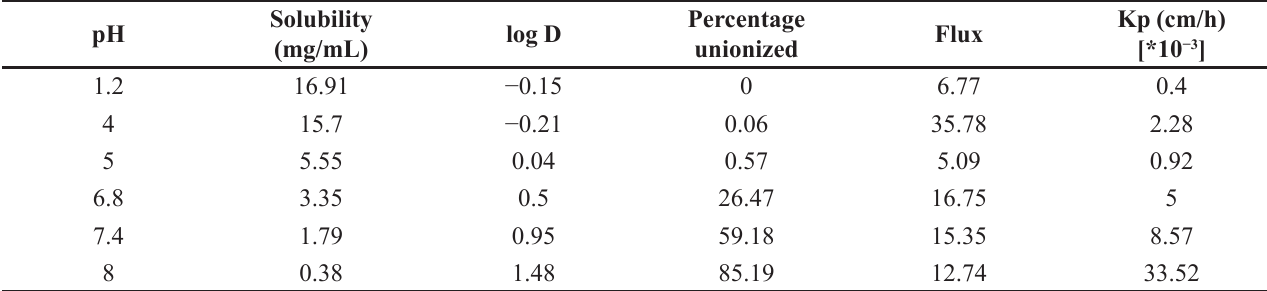
TABLE IV - Solubility, distribution coefficient, percentage unionized, and skin permeability parameters of olanzapine pH